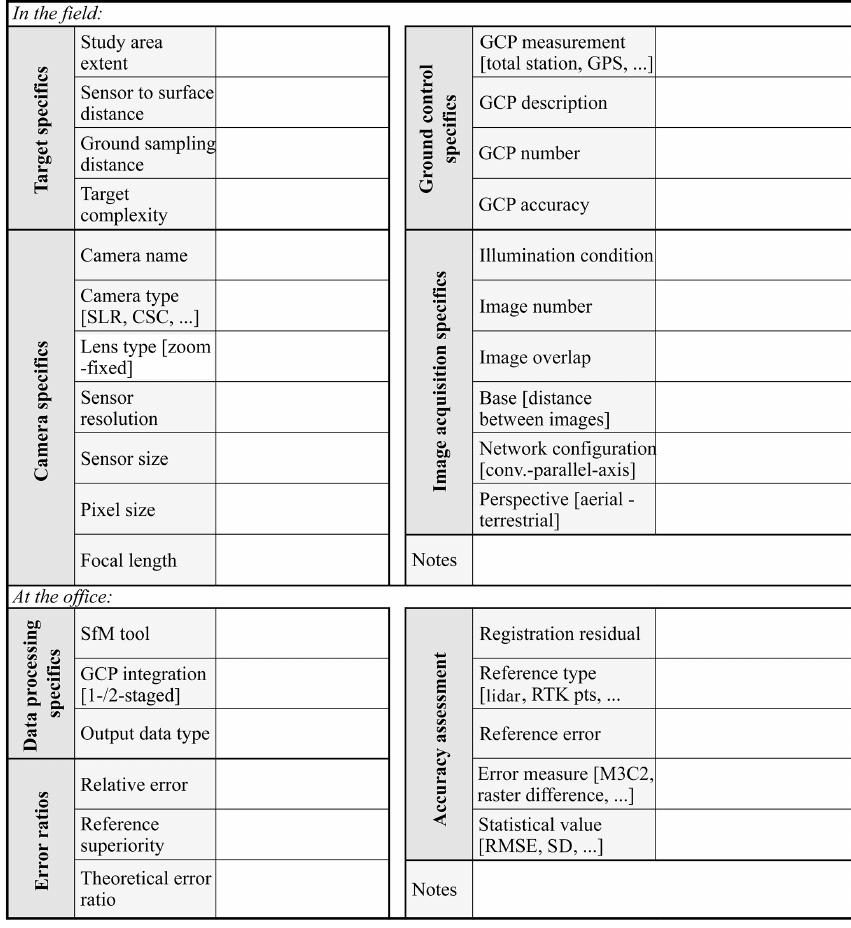
Figure 6. Data acquisition and error assessment protocol for SfM photogrammetry, independent of individual study